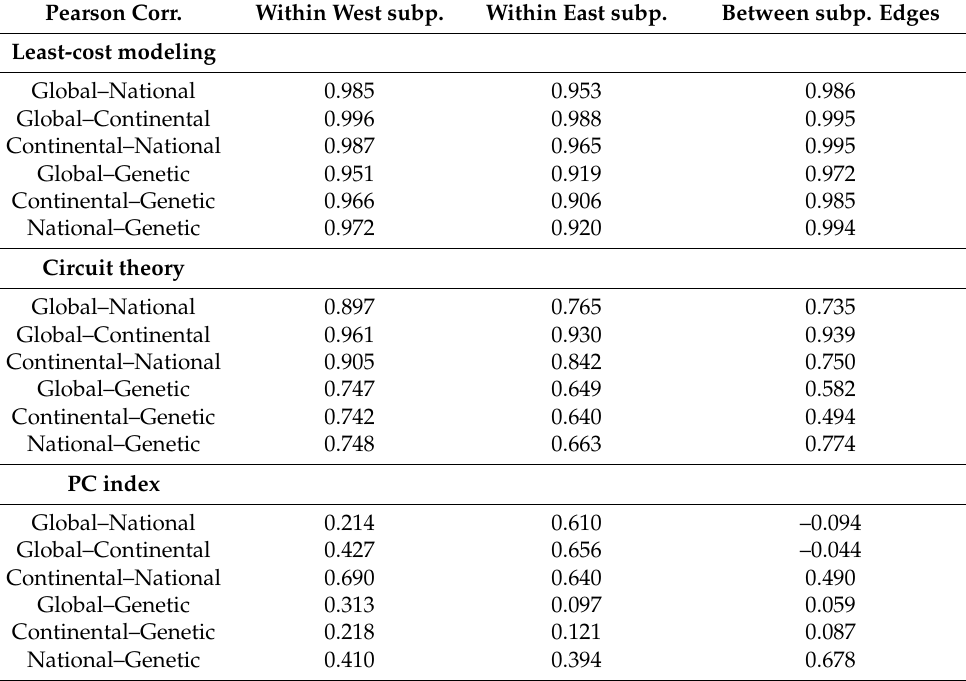
Table 3. Pearson’s correlation of connectivity metrics: effective (least-cost modeling) and resistance (circuit theory) distances, and difference in probability of connectivity index (dPC) values (PC index) between the paired combinations of global, continental and national models and of each of these three models against the genetic model for each subpopulation (subp.) and between subpopulation edges. Pearson Corr. Within West subp. Within East subp. Between subp.